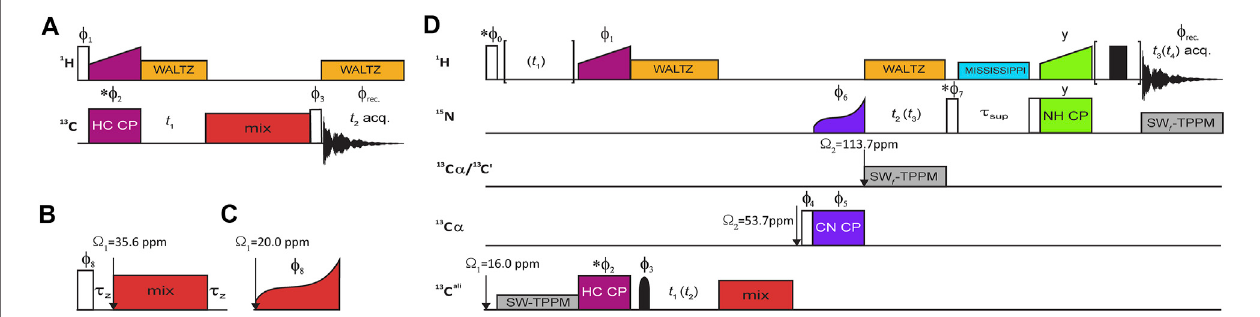
FIGURE2| RFirradiationschemesofNMRexperiments. (A) 13 C – 13 C2Dcorrelationexperimentwithmixingtwovariantsof 13 Cmixingexpandedin (B) and (C) .All schemes act on the 13 C magnetization preceded and followed by a z - fi lter ( τ z ) (B) with the exception of DREAM (C) , which operates on the 13 C single-quantum coherence. (D) Pulse diagram for 3D (H)C MET (CC)(CA)NH, with the optional evolution period for methyl 1 H coherences enclosed in brackets (for the 4D variant). The optional 1 H spin echo immediately before acquisition was only applied for Bruker 1.3-mm probe to eliminate probe 1 H background signal. Open and solid rectanglesrepresent90 ° and180 ° high-powerpulses,respectively,andasolidbellshapedenotesamethyl 13 C-selectiveQ3refocusingpulse(EmsleyandBodenhausen 1992) of 942.7 μ s duration and peak RF of ν 1 = 2.56 kHz. 13 C mixing is marked in red , and cross-polarization transfer steps are labeled and color-coded as maroon , purple ,and limegreen simultaneousirradiationonpairsofrespectivechannelsforH → C,C → N,andN → Htransfers. 1 Hlow-powerWALTZ(Shaka, Keeler,andFreeman 1983) decoupling ismarked in orange , while heteronuclear ( 13 Cor 15 N) frequency-swept TPPM decoupling (Bennett et al., 1995) ismarked in gray . MISSISSPPI solvent suppression(ZhouandRienstra2008)ismarkedin cyan .Changesin 13 Coffset( Ω )aredenoted withvertical arrows.Unlessindicatedotherwise,allpulsephases areset to x .Thefollowingphasecyclingwasemployed: ϕ 1 = y , ϕ 2 = y , ϕ 3 ={2( x ),2( − x ),2( y ),2( − y )}, ϕ 8 ={ x , − x }, ϕ rec. ={ x, − x , − x , x,y, − y, − y,y }for2Dexperimentwithinset (B) ; ϕ − y }, ϕ − x )} , ϕ − x )}, ϕ − x )}, ϕ − x,x, − x }for2DDREAMexperiment(A+C); ϕ − y )}, ϕ ϕ ϕ 1 ={ y, 2 ={2( x ),2( 3 ={4( x ),4( 8 ={2( x ) , 2( rec. ={ x, 1 ={4( y ),4( 2 = x , 3 ={ x , x , y , y }, 4 = y , ϕ − x )}, ϕ – y }, ϕ ϕ ϕ – x, – x,x, – x,x,x, – x, – x,x, – x,x, – x, – x,x }for3Dexperiment(D)withrecouplingblock(B);and ϕ − y )}, ϕ 5 ={8( x ),8 6 ={ y, 7 = x , 8 =- y , rec. ={ x, 1 ={8( y ),8( 2 = {4 ( x ), 4 ( − x ) }, ϕ 3 = {2 ( x ), 2 ( y ), 2 ( − x ), 2 ( − y )}, ϕ 4 = x , ϕ 5 = x , ϕ 6 = { y , − y }, ϕ 7 = { x }, ϕ 8 = {4 (x), 4 ( – x )}, ϕ rec. = { x, – x, – x, x, – x, x, x, – x, – x, x, – x, x, – x, – x, x } for 3D